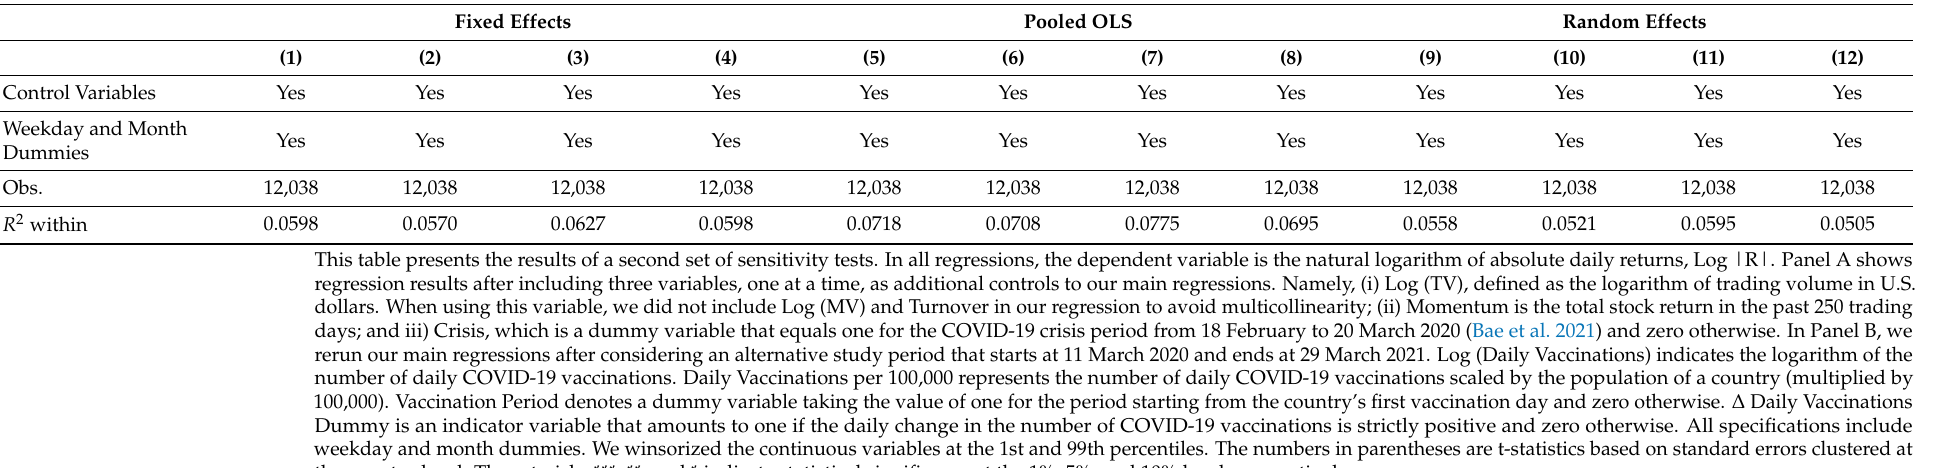
Panel B: Alternative Study Period (Starting from 11 March